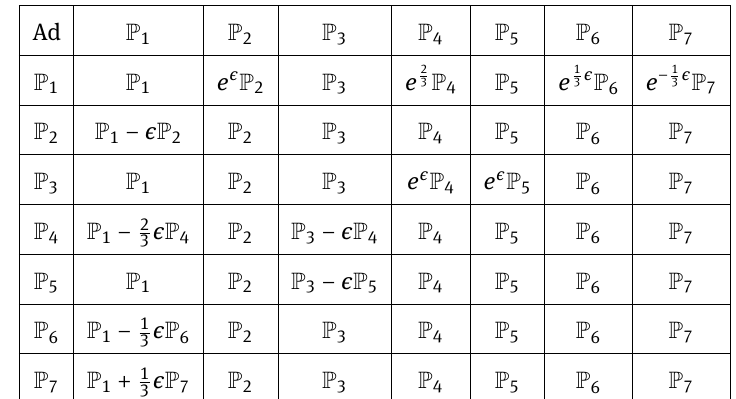
Table 2: Adjoint Table